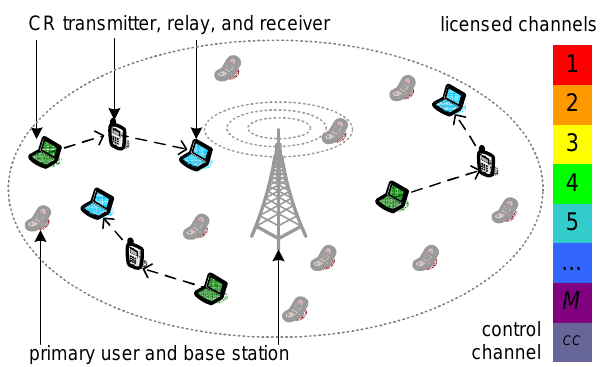
Figure 1. The discrete-time two-state Markov model for channel m , m = 0 , 1 , . . . , M − 1 .